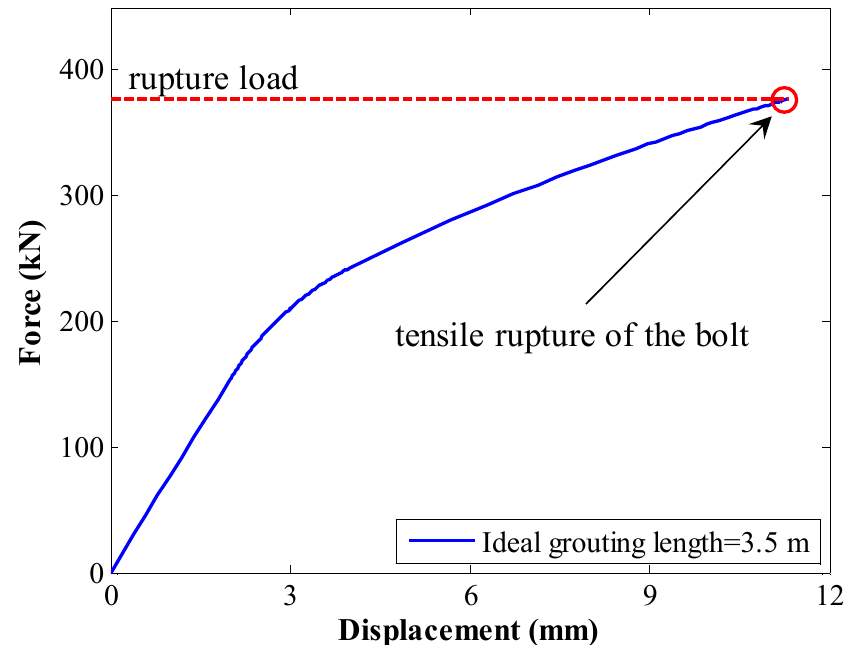
Figure 10. Reverse-calculating the ideal grouting length of the bars.